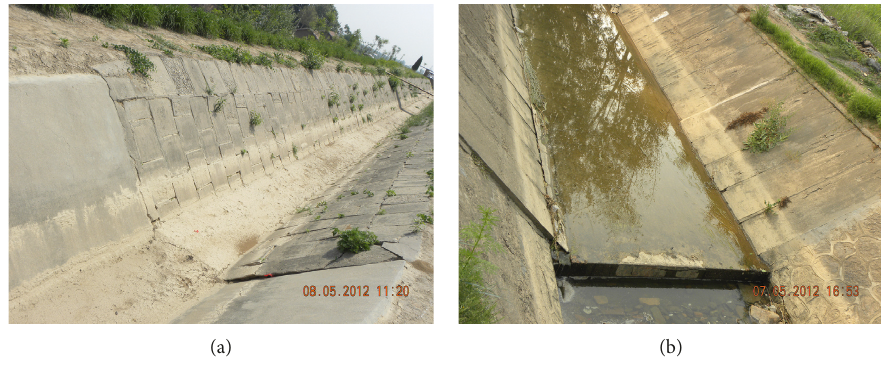
Figure 1: Frost damage in irrigation canals. (a) Swelling of lining. (b)